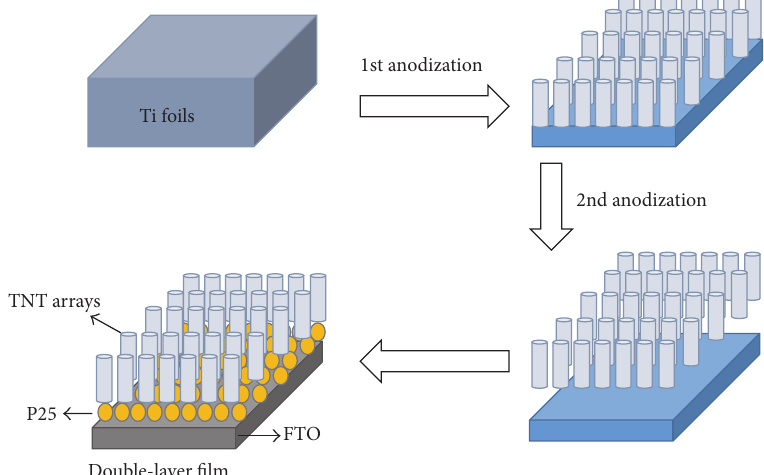
Figure 4: Schematic illustrating the fabrication process of P25/TNT arrays double-layer composite